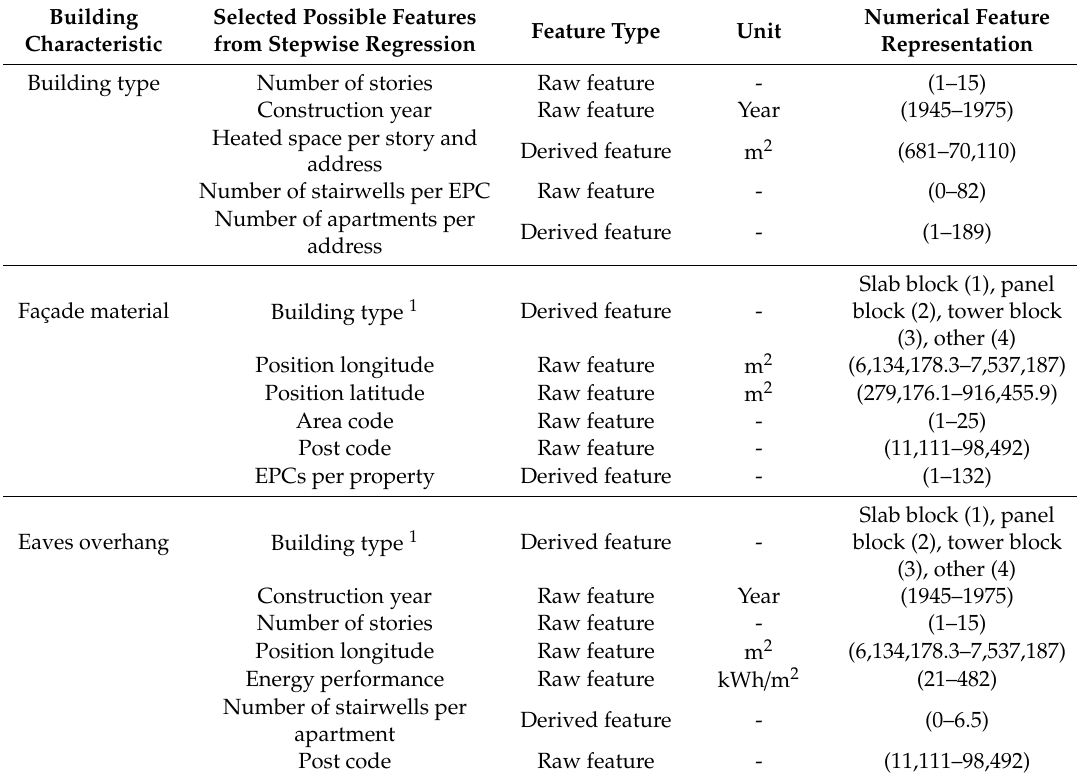
Table 6. The selected features (from available EPC data) to consider for the prediction of each building